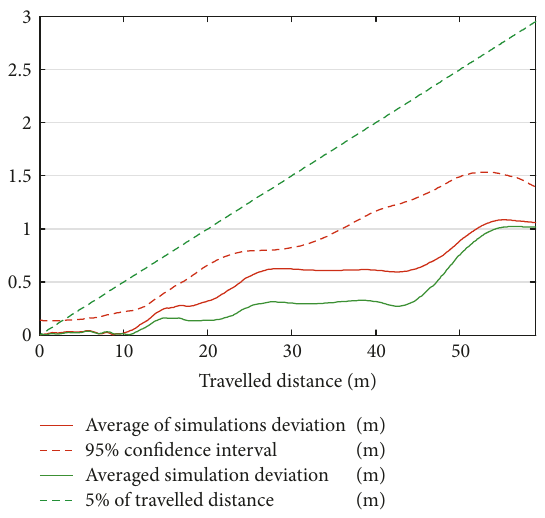
Figure 19: Validation combined dynamics: travelled-distance domain.